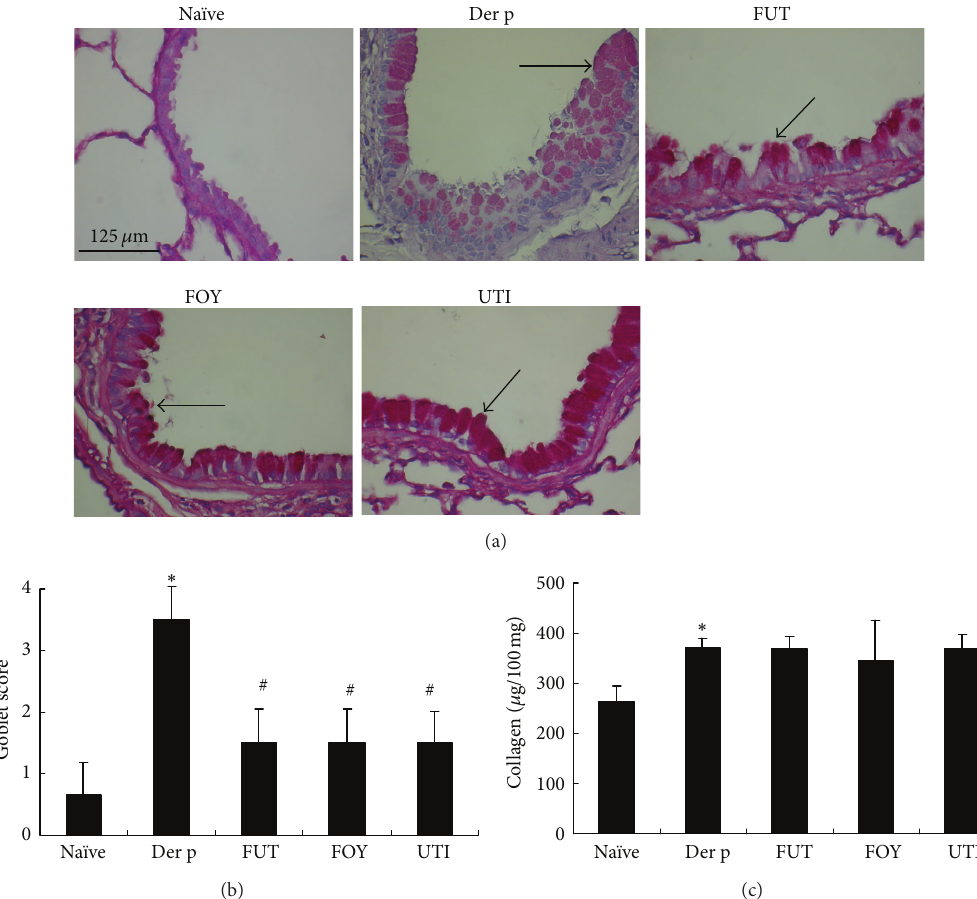
Figure 3: Effects of protease inhibitors on Der p-induced airway inflammation, goblet cell hyperplasia, mucus hypersecretion, and collagen deposition in mouse lung tissues. (a) Goblet cells (PAS; original magnification, × 400) in airway epithelial cells and (b) goblet cell hyperplasia was scored on a 5-point scale (0–4). (c) Collagen contents in lung tissue results are expressed as means ± SD’s for 6 mice/group. ∗ 𝑃 < 0.05 versus na¨ıve group; # 𝑃 < 0.05 between Der p-treated